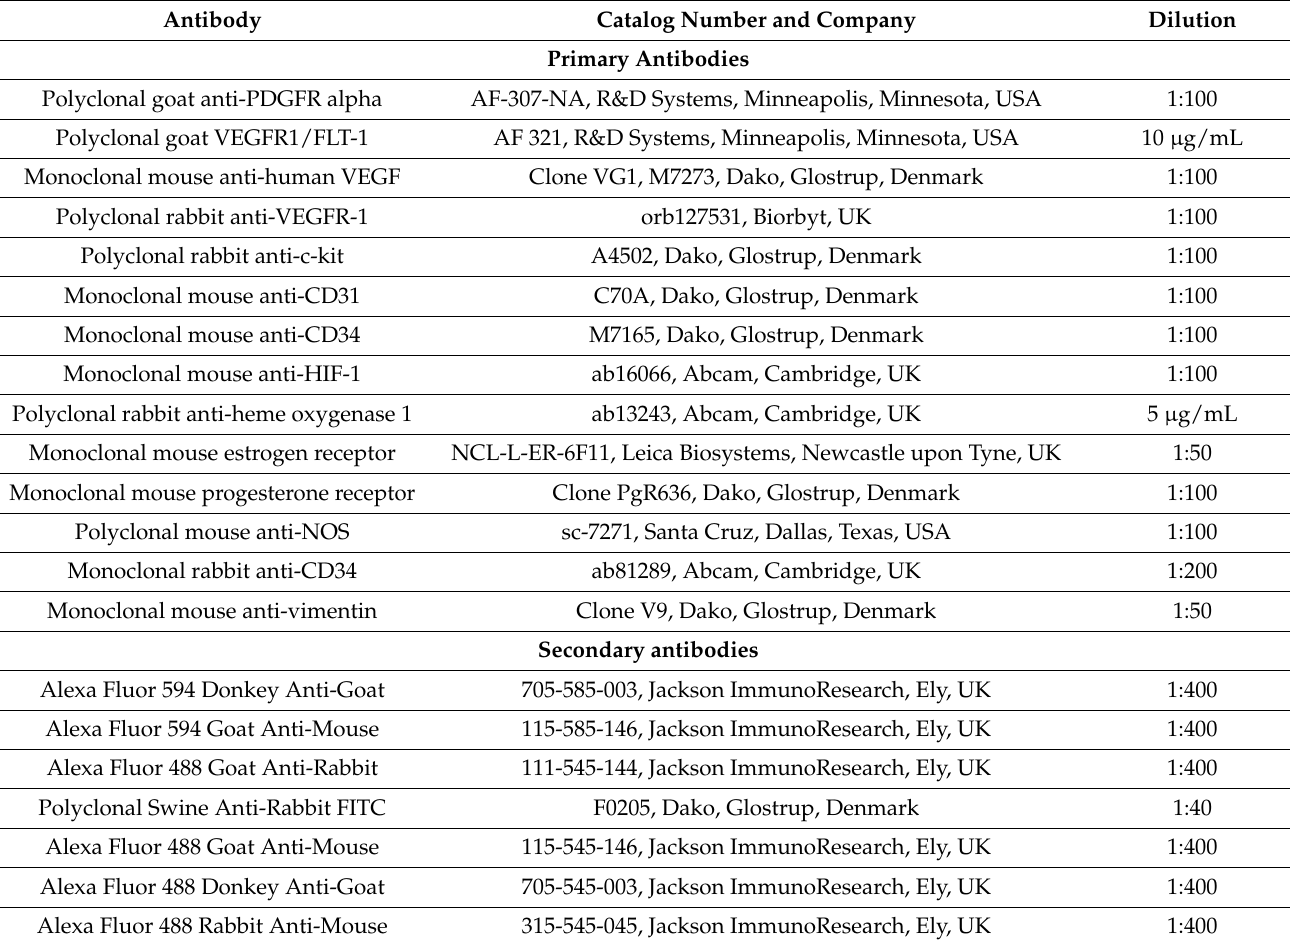
Table 3. Type, sources, and dilution of